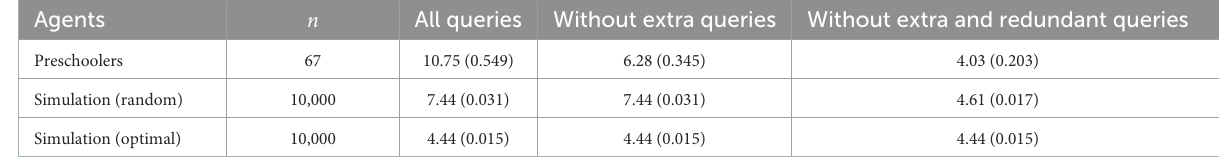
TABLE 1 Mean scores and standard errors of number of queries by agents (participants and simulated random and optimal agents). Agents n All